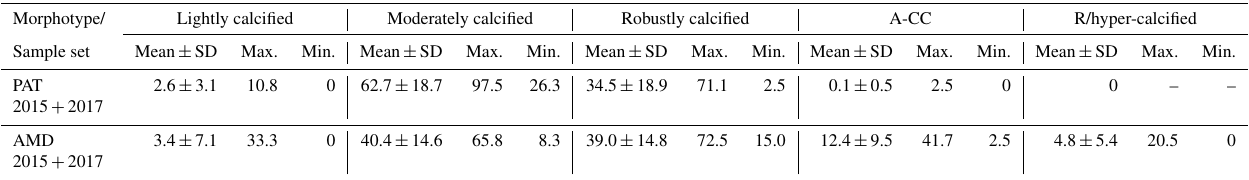
Table 3. Relative percentages of E. huxleyi A morphotypes recorded throughout southern Patagonia fjords. Mean, standard deviation (SD), and maximum and minimum percentages of five E. huxleyi morphotypes recorded in inner surface waters of southern Patagonia (PAT; n = 883 cells counted in 23 samples) and down to 50m in the Archipelago Madre de Dios western zone (AMD; n = 1012 cells counted in 27 samples) during the late austral spring 2015 and early spring